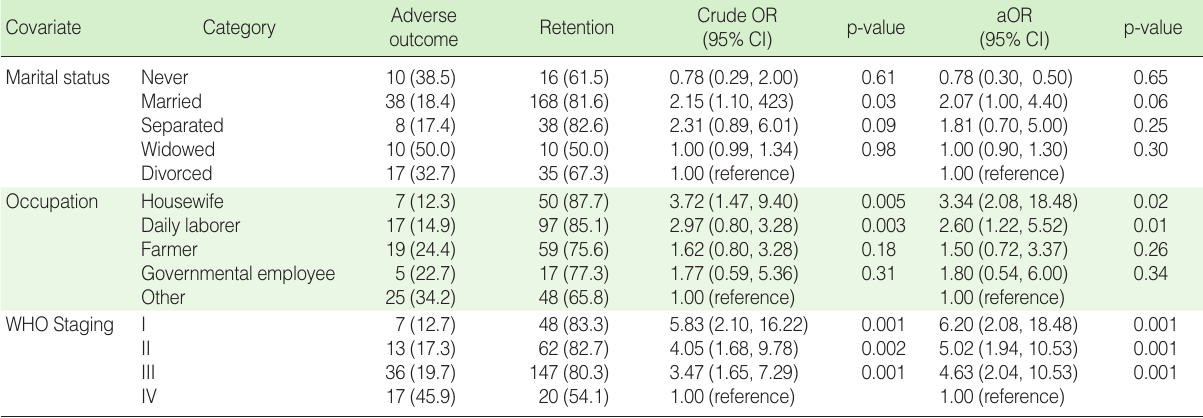
Table 5. Factors affecting ART retention rate and adverse outcomes of patients receiving ART at Jinka Zonal Hospital, Jinka, South Omo, Ethiopia in 2016 (n=350)